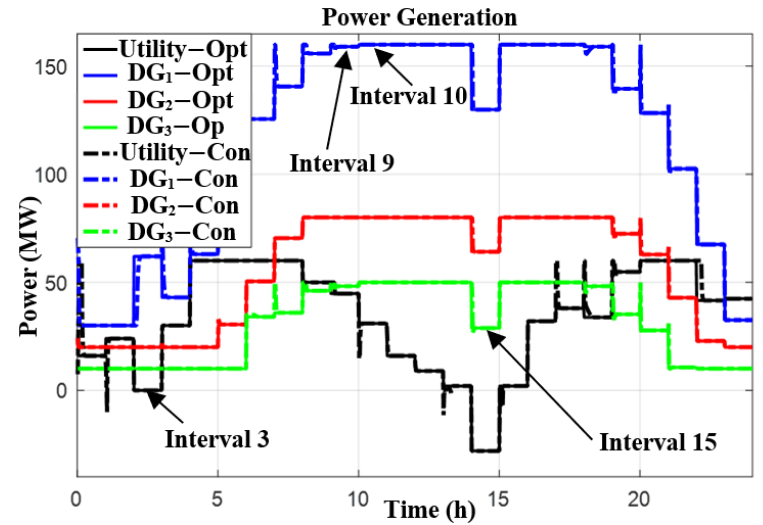
Figure 13. Power generation of DDGs under a heavy load scenario.